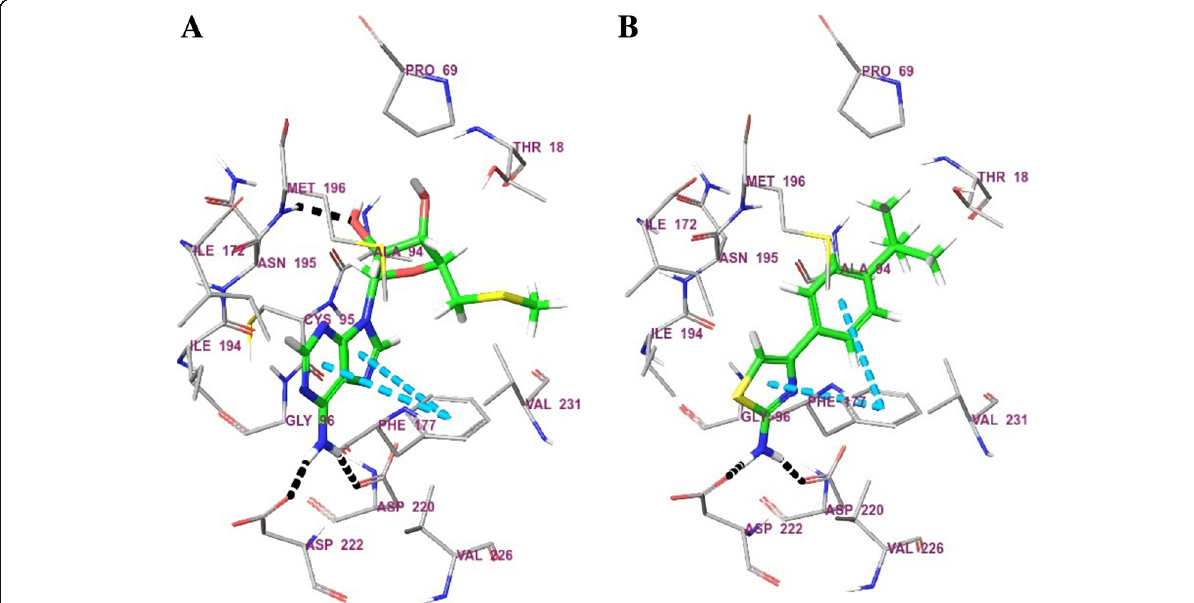
Fig. 1 Docking at the S-methyl-5-thioadenosine phosphorylase. (a) Co-crystallized ligand. ( b) Compound 6 docked at the active site. Blue dashed lines: pi-stacking interactions; black dashed lines: hydrogen bonds (For color version, please access the online version of the